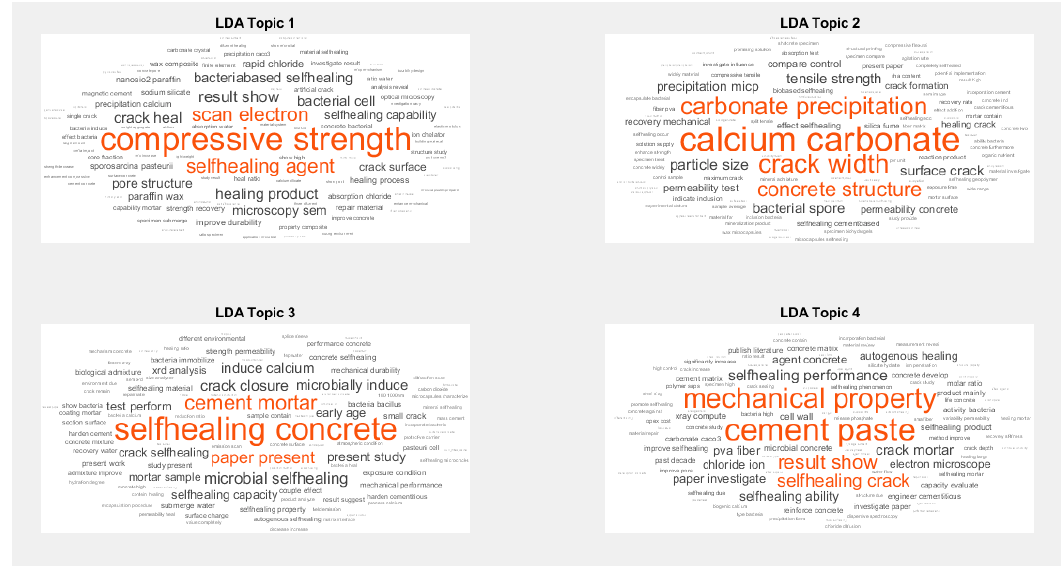
Figure 2. Four LDA topics generated through MATLAB (Abstract + Keywords).